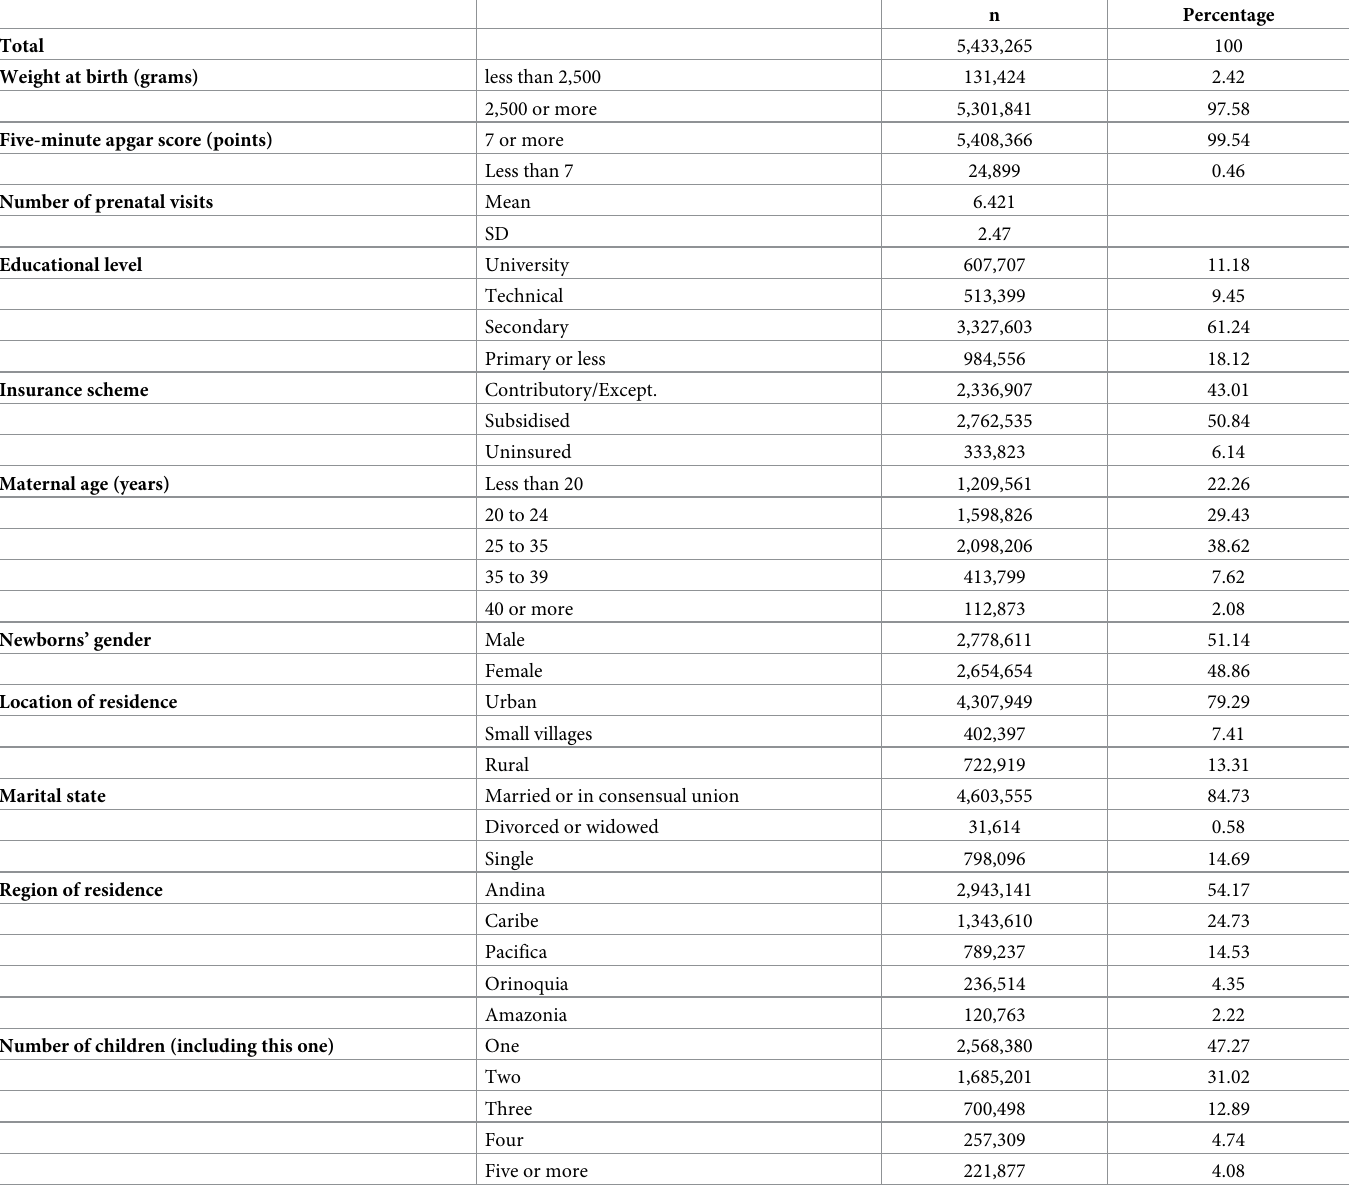
Table 1. Characteristics of births analysed for the whole study period